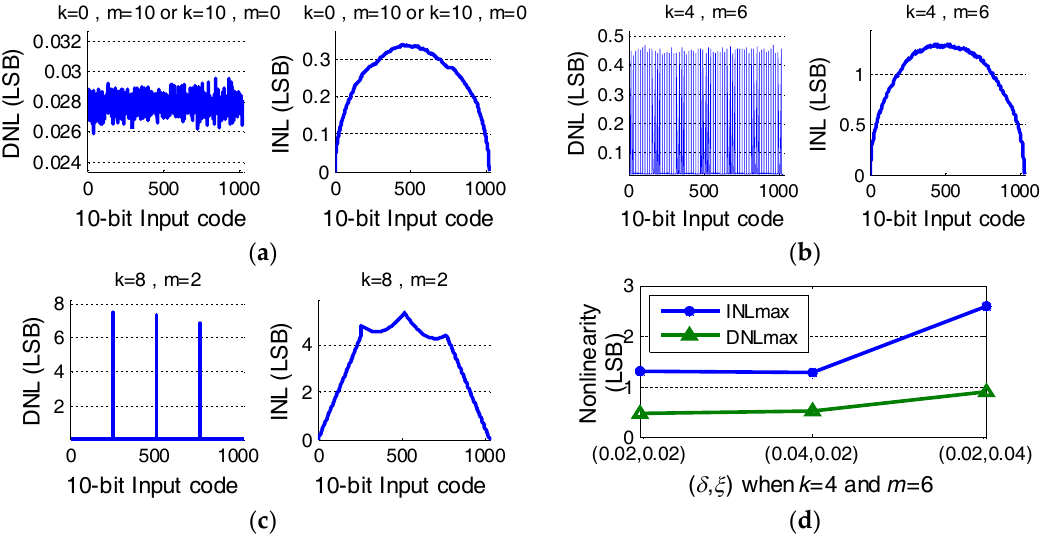
Figure 3. The standard deviation (STD) of differential nonlinearity (DNL) and integrated nonlinearity (INL) of 1000 Monte Carlo MATLAB simulations. ( a – c ) show the results when δ = ξ = 0.02 and segmentation (k/m) varies: ( a ) k = 0, m = 10 or k = 10, m = 0, ( b ) k = 4, m = 6, ( c ) k = 8, m = 2. ( d ) is the maximum STD of DNL and INL when k = 4, m = 6, and ( δ , ξ ) varies.